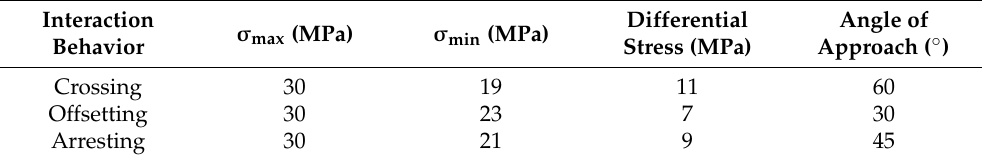
Table 3. Typical cases under different approach angles and differential stresses in Zangeneh et al. [12].